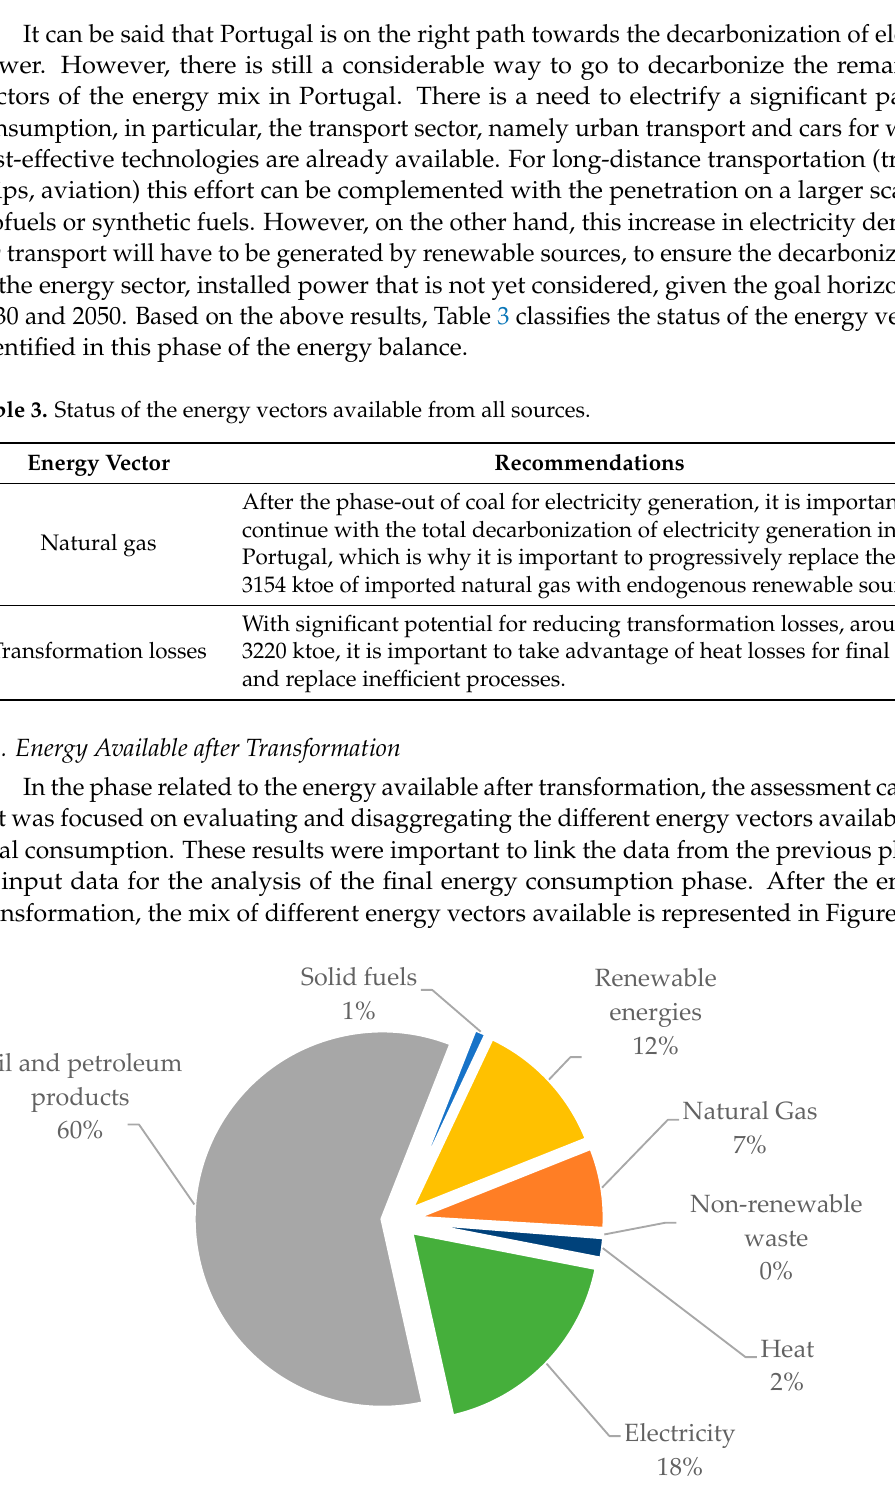
Table 3. Status of the energy vectors available from all sources.